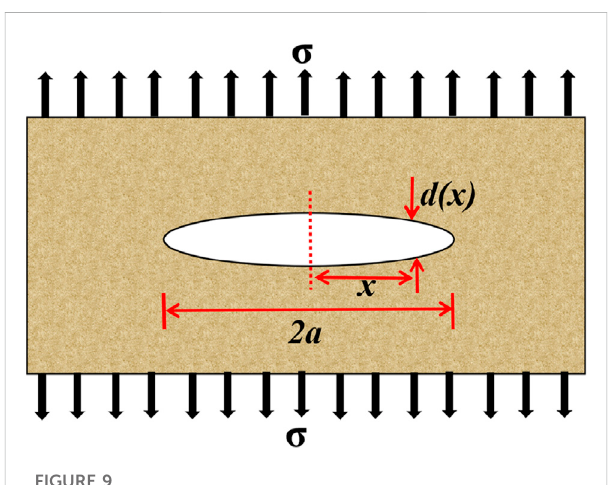
FIGURE 9 Schematic of the growth conditions derivation of Grif fi th